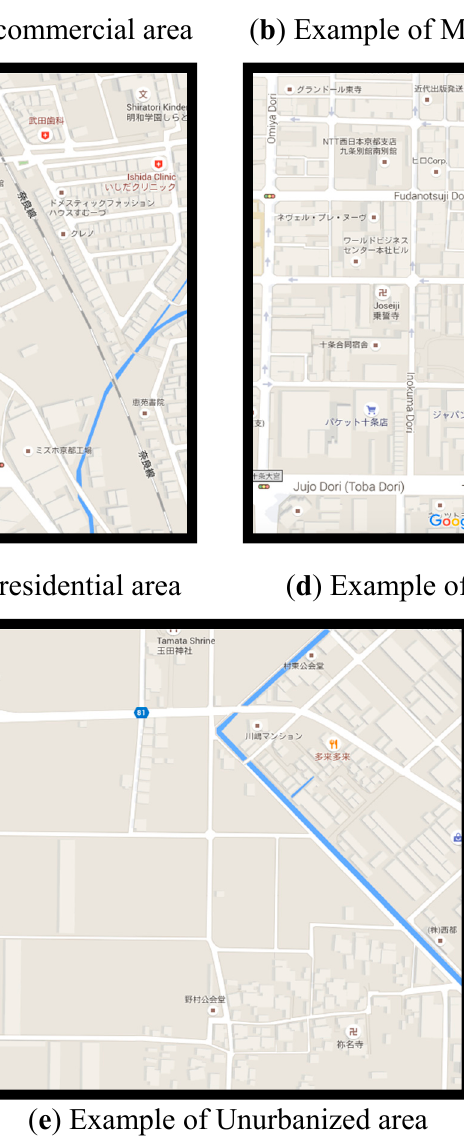
Figure 3. Map examples of the different area types (images from Google Maps).